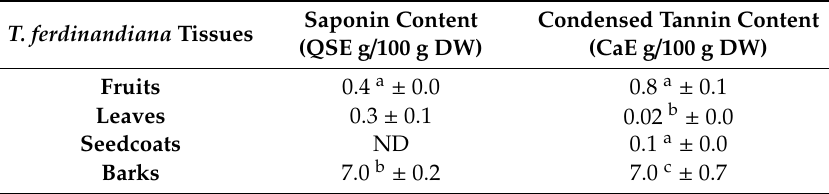
Table 3. Saponins and condensed tannins in T. ferdinandiana tissues.